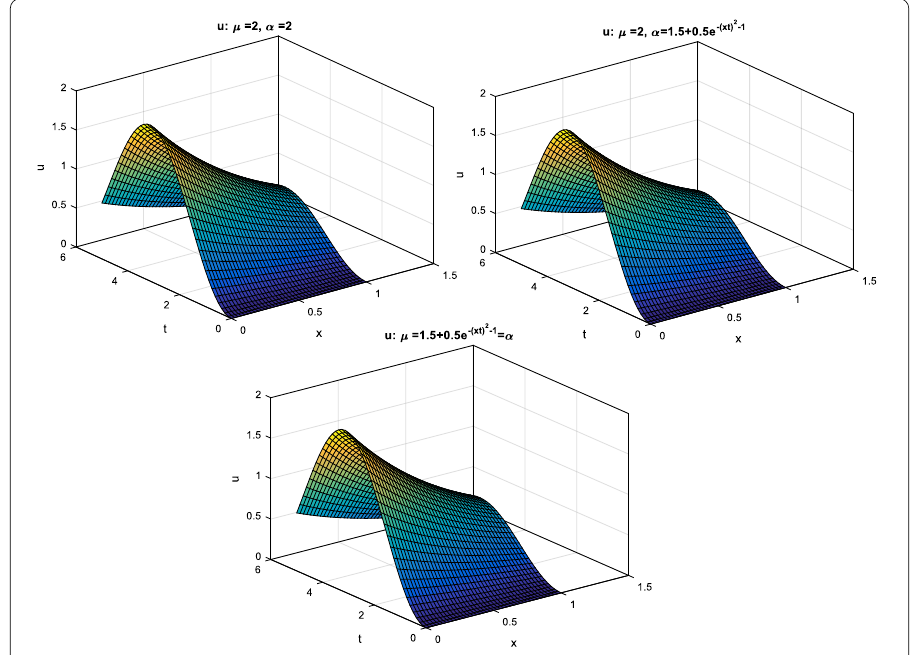
Figure 2 Comparison of the approximate solutions utilizing the introduced method in Example 1 for various values of μ , α